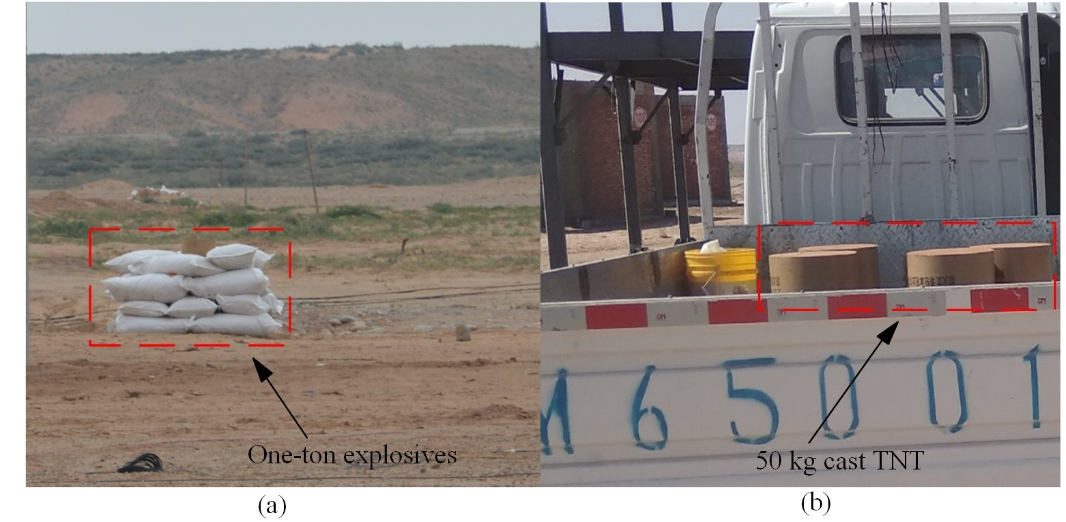
Figure 1. TNT charges for tests, ( a ) the explosives and ( b ) the cast TNT.